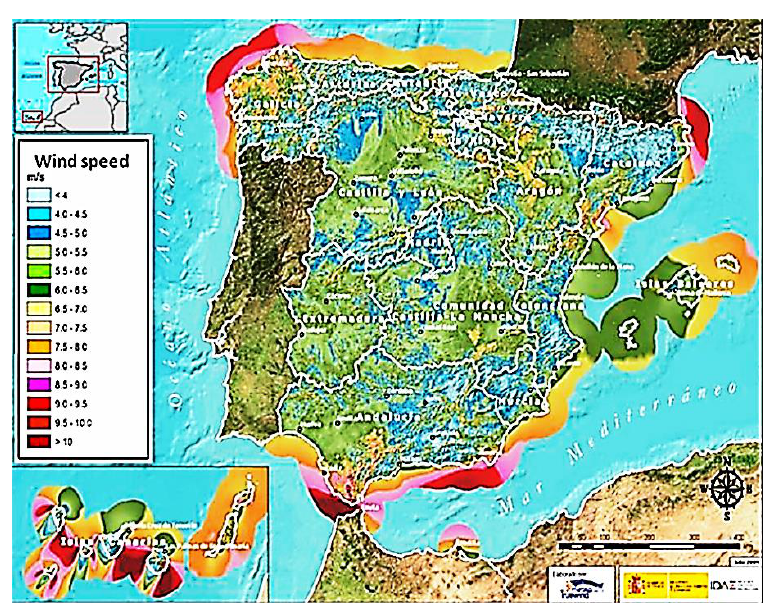
Figure 11. Map with the annual average wind speed, in m/s, at 80 m high (Reproduced with permission from [71]. IDEA, 2019). Table 1. Annual average wind speed, in m / s, in all the areas in the Spanish